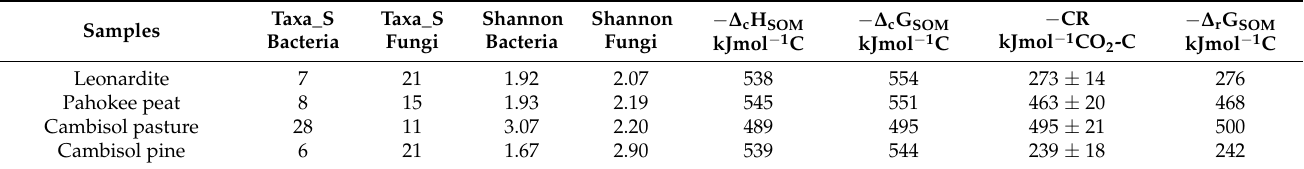
Table 5. Biological and thermodynamic properties determined for four different mineral soil samples. Microbial diversity was determined by ARISA and is given by the Taxa_S and Shannon_H diversity indices for soil bacteria and fungi. Reproducibility for − ∆ c H SOM is 5%. The residual standard error is 21.5 kJ mol − 1 . CR values are the average of duplicates with their standard